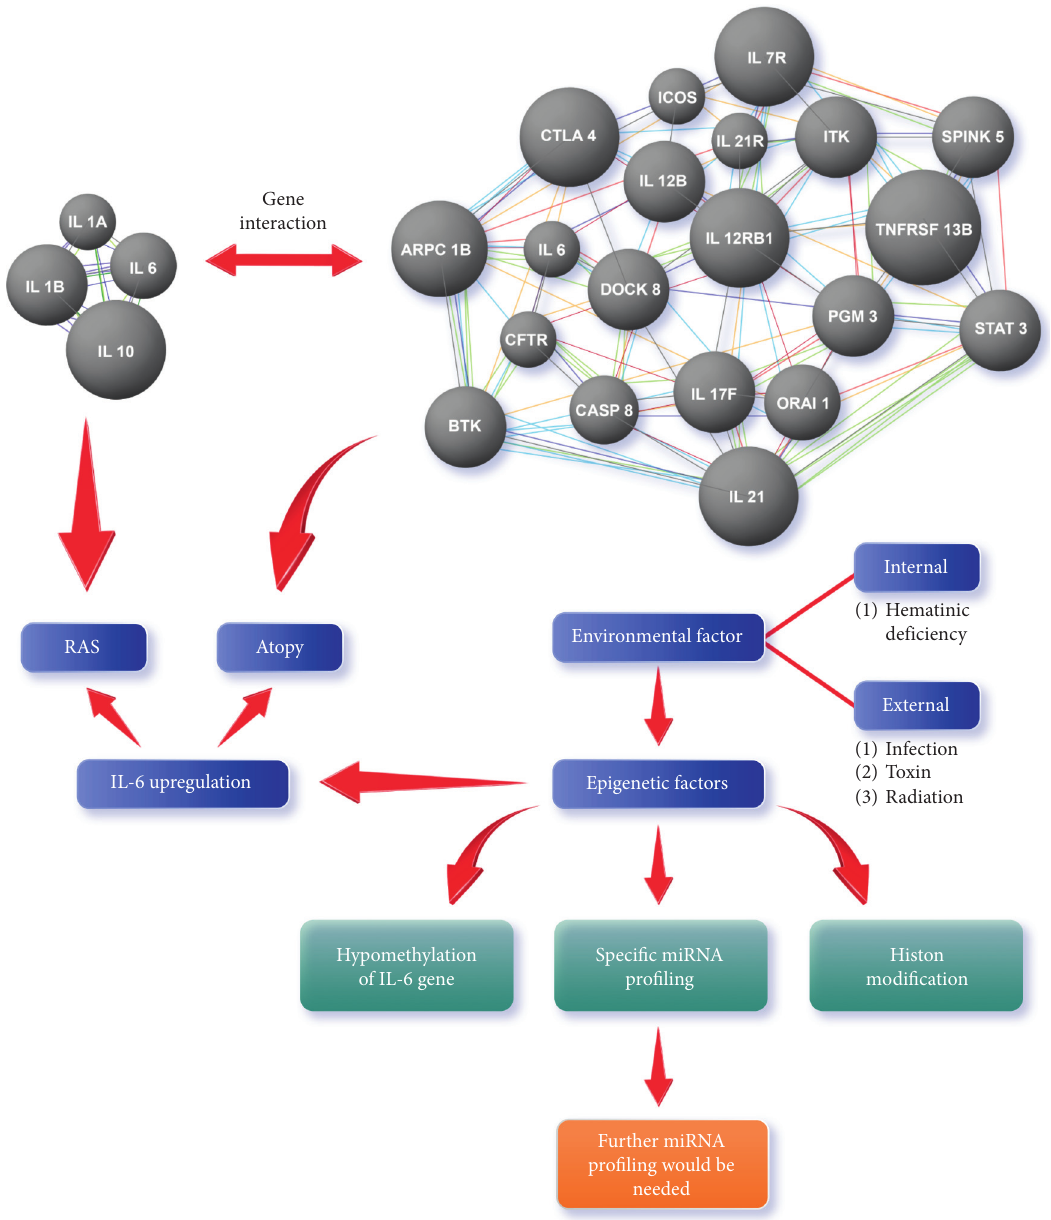
Figure 1: Overview of the genomic and epigenomic analysis of the three related conditions: recurrent aphthous stomatitis (RAS), atopy (such as rhinitis allergy, bronchial asthma, and dermatitis atopy), and hematinic deficiency. The grey balls are genes responsible for RAS (left side) and atopy (right side). They interact by coexpression, sharing protein domain, and even direct gene interaction [37]. IL6 is the most important proinflammatory gene affecting RAS and atopy, while its upregulation is interfered with by some external factors (infection, toxin, or radiation), internal factors (folic acid, iron, or B-12 deficiency), as an environmental factor. Also, some epigenetic factors interfere with IL6 gene expression. Strong evidence support hematinic deficiency as a crucial internal environmental factor that affects DNA methylation of some genes. There is no previous study that analyzes the DNA methylation of some important genes in RAS, notably linking with the history of